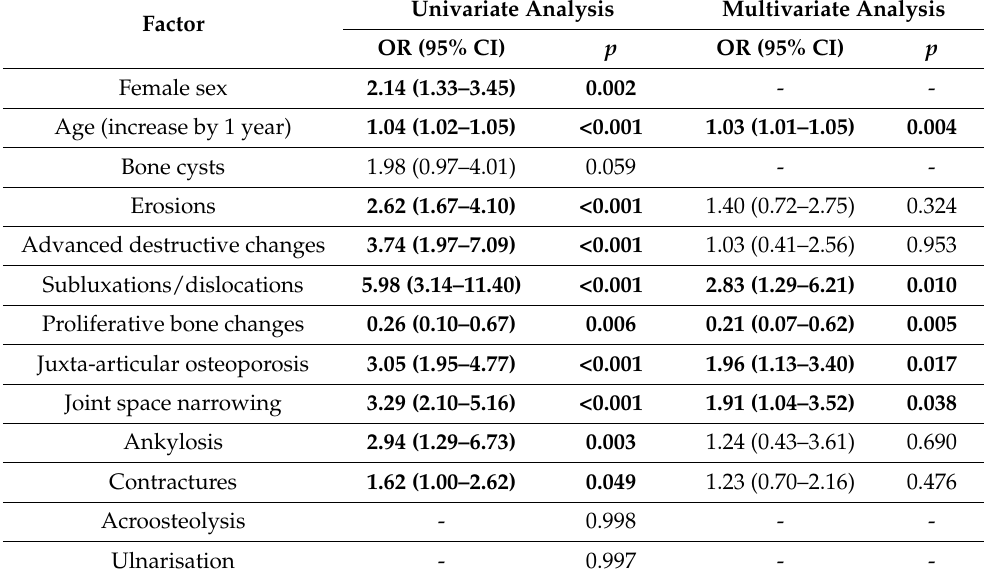
Table 7. Logistic regression for the dependent variable of seropositive RA vs. the independent variable of PsA considering the types of